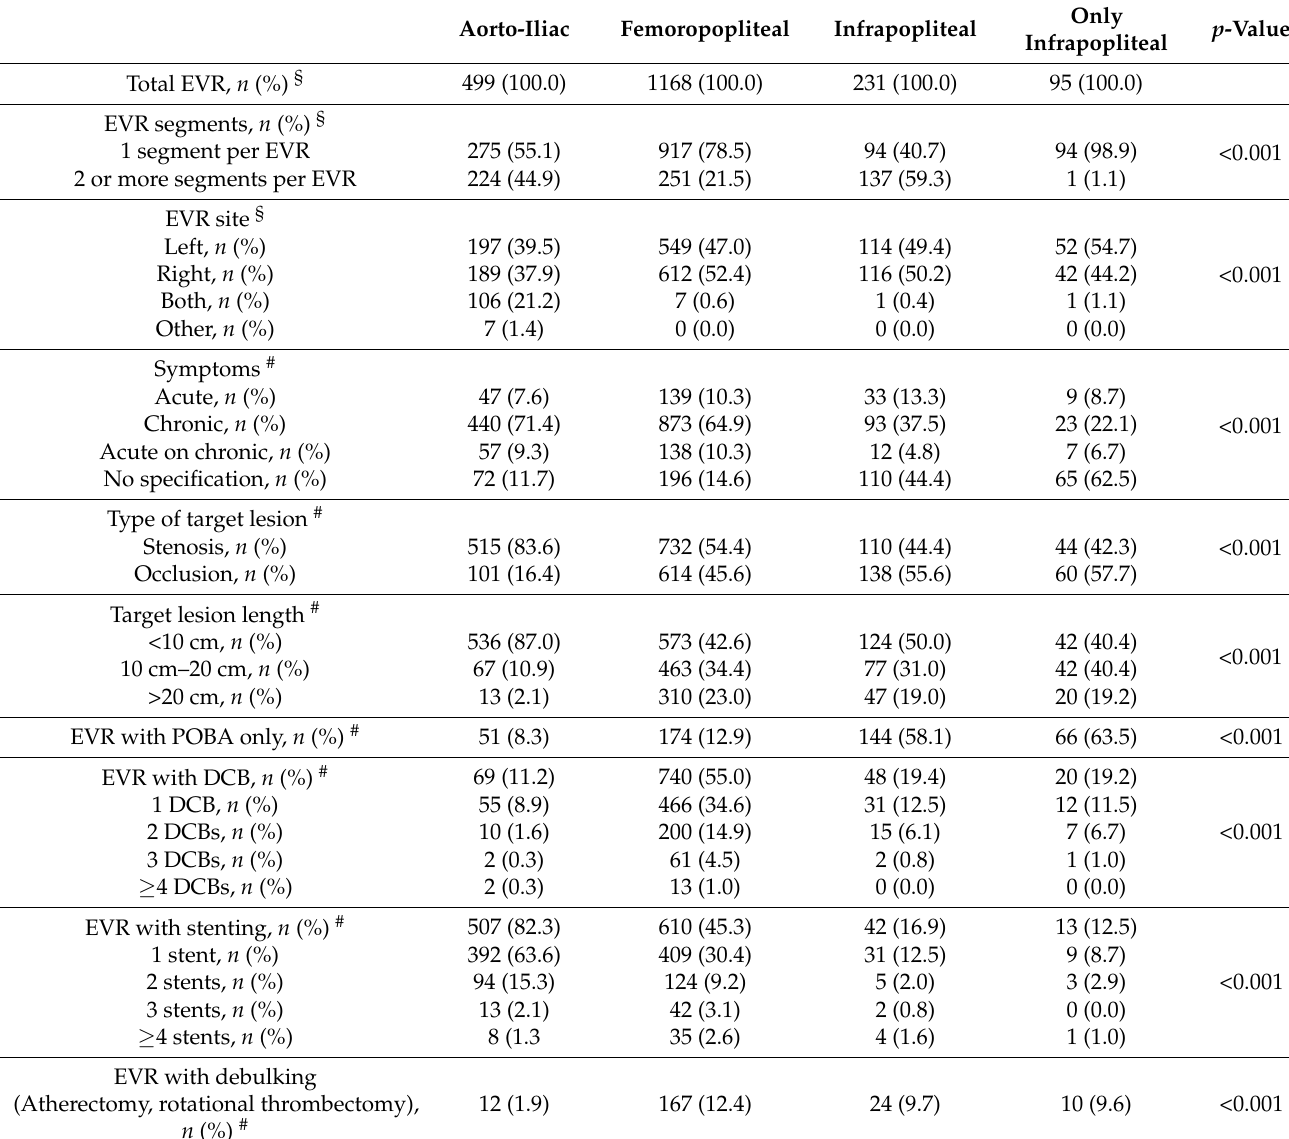
Table 2. Procedural